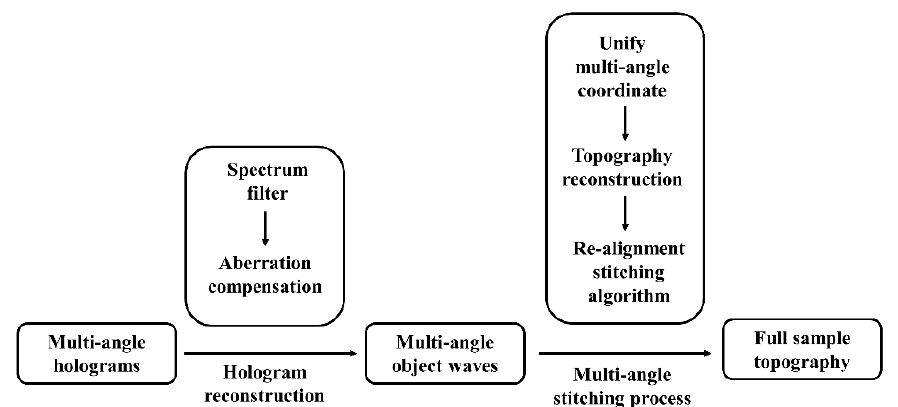
Figure 3. The algorithm flow chart of the data processing.